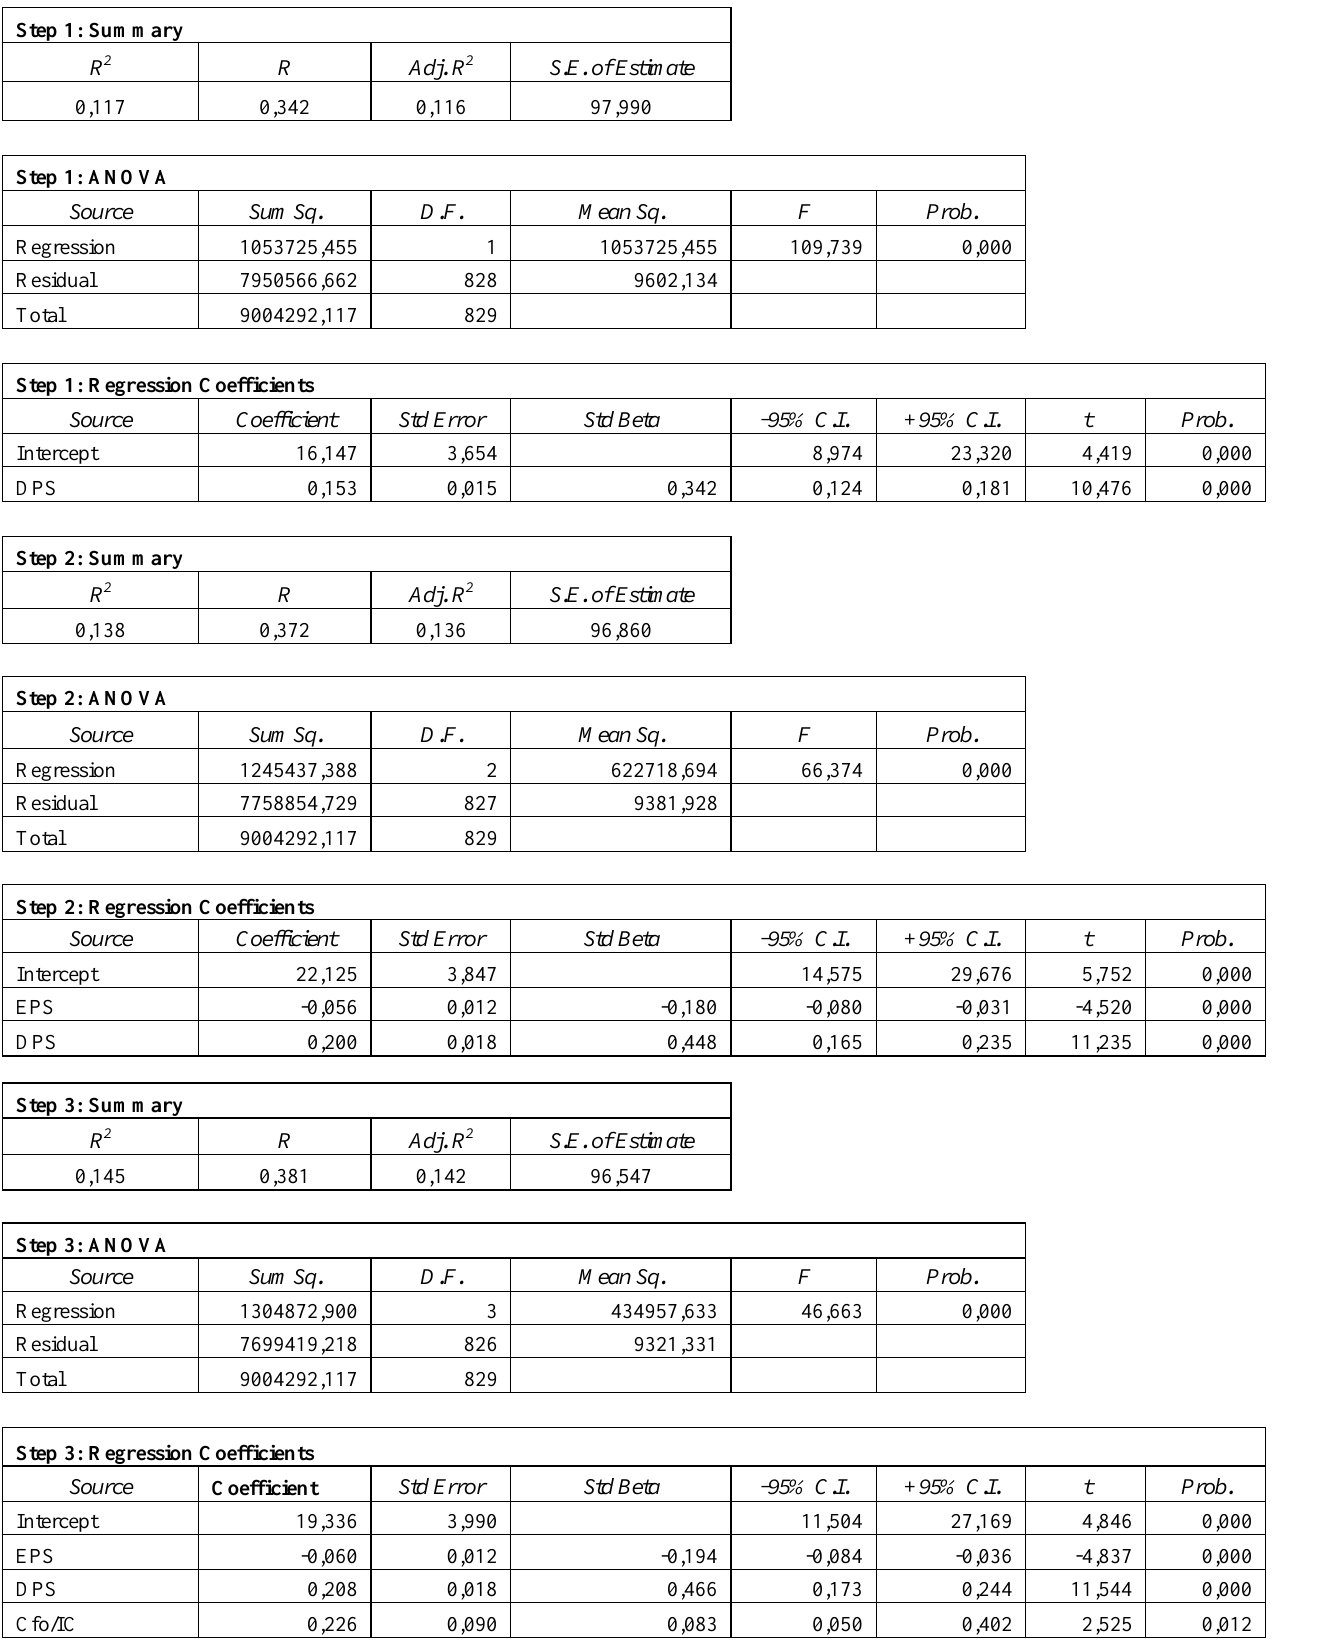
Table 4: Stepwise regression of shareholders’ returns with ROE and other independent variables, excluding